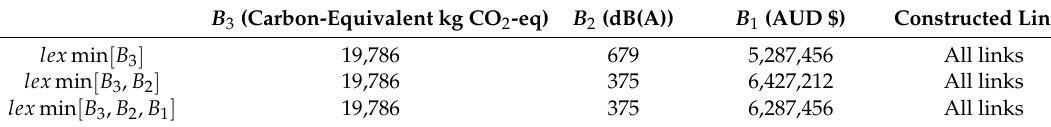
Table 4. Lexicographic optimisation with the order B 3 (cid:31) B 2 (cid:31) B 1